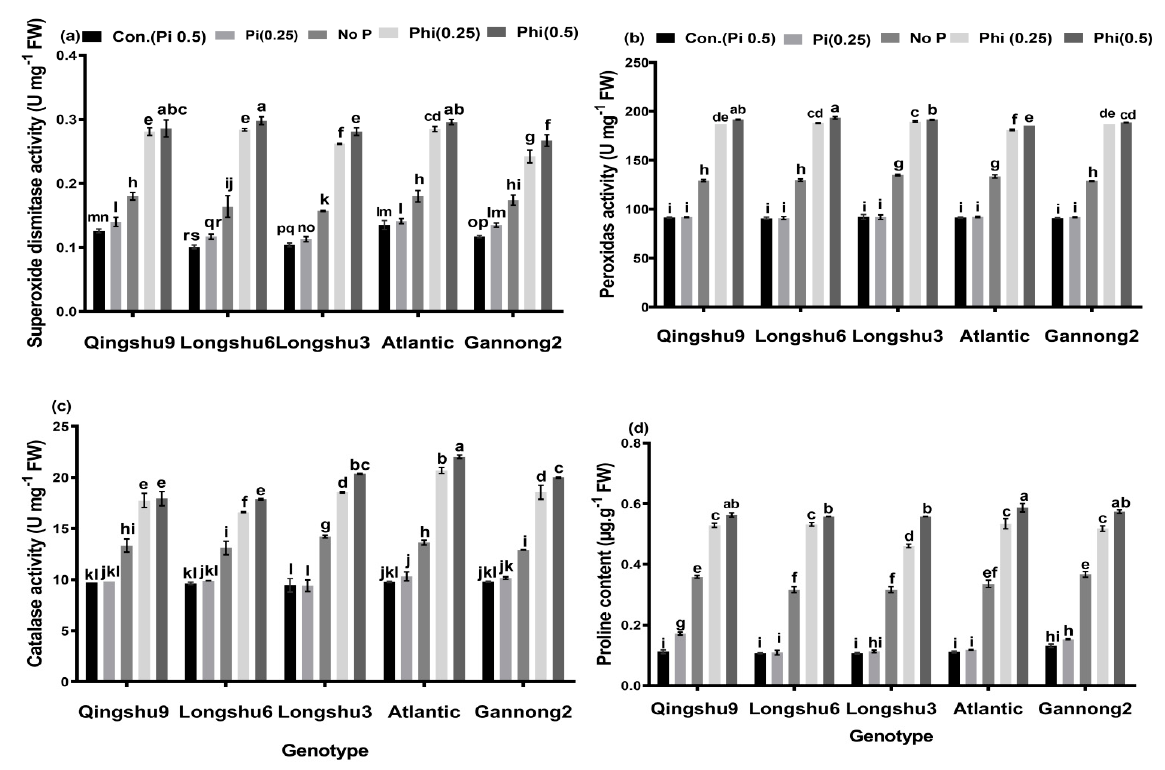
Figure 5. Phi and Pi effects on enzyme activities and contents of proline; ( a ) Shows the activities of SOD; ( b ) Shows the activities of POD; ( c ) Shows the activities of CAT; ( d ) Contents of proline. Values denote the mean of 3 replications ± standard deviation (SD). Bars associated with different lowercase letters show significant differences by Duncan Multiple Range’s test ( p ≤ 0.05).